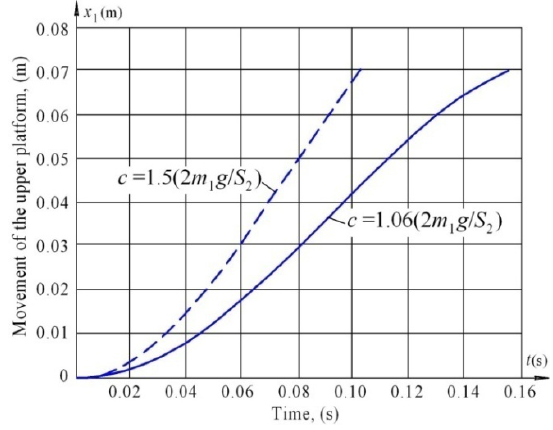
Figure 5. Influence of stiffness " c " of a mechanical spring to move the upper platform ( D =0.2(m); d =0.04(m); S 2 =0.35 D (m); m 1 =40(kg)